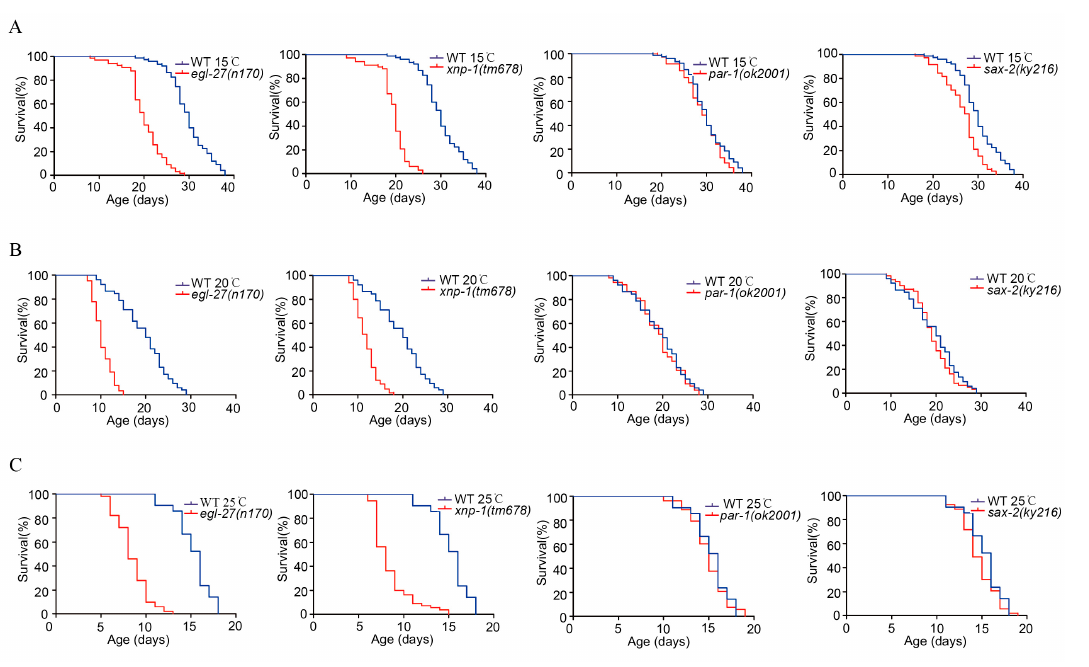
Figure 7. Temperature-responsive phosphoproteins are essential modulators of the worm lifespan. ( A ) The lifespans of egl-27 and xnp-1 mutants were significantly reduced at 15 ◦ C ( p < 0.01, log-rank test). The lifespans of sax2 and par-1 mutants were not reduced at 15 ◦ C ( p > 0.05, log-rank test). ( B ) The lifespans of egl-27 and xnp-1 mutants were significantly reduced at 20 ◦ C ( p < 0.01, log-rank test). The lifespans of sax2 and par-1 mutants were not reduced at 20 ◦ C ( p > 0.05, log-rank test). ( C ) The lifespans of egl-27 and xnp-1 mutants were significantly reduced at 25 ◦ C ( p < 0.01, log-rank test). The sax2 and par-1 mutants were not significantly reduced at 25 ◦ C ( p > 0.05, log-rank